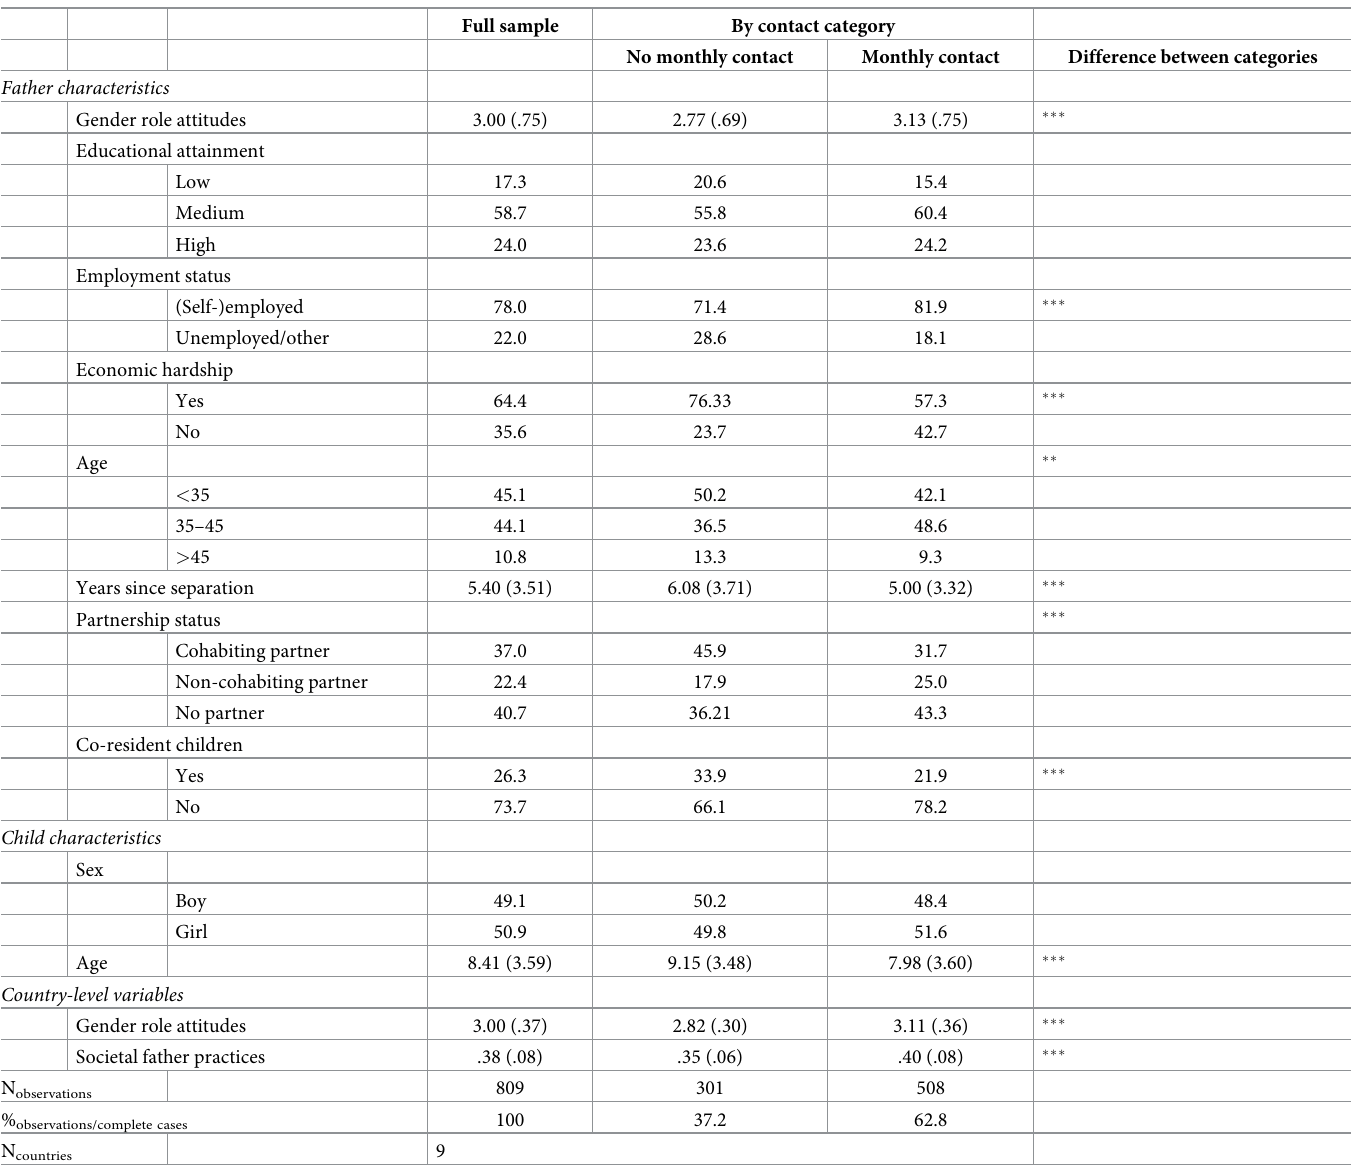
Table 3. Descriptive statistics for the childhood-sample (percentage or mean and standard deviation